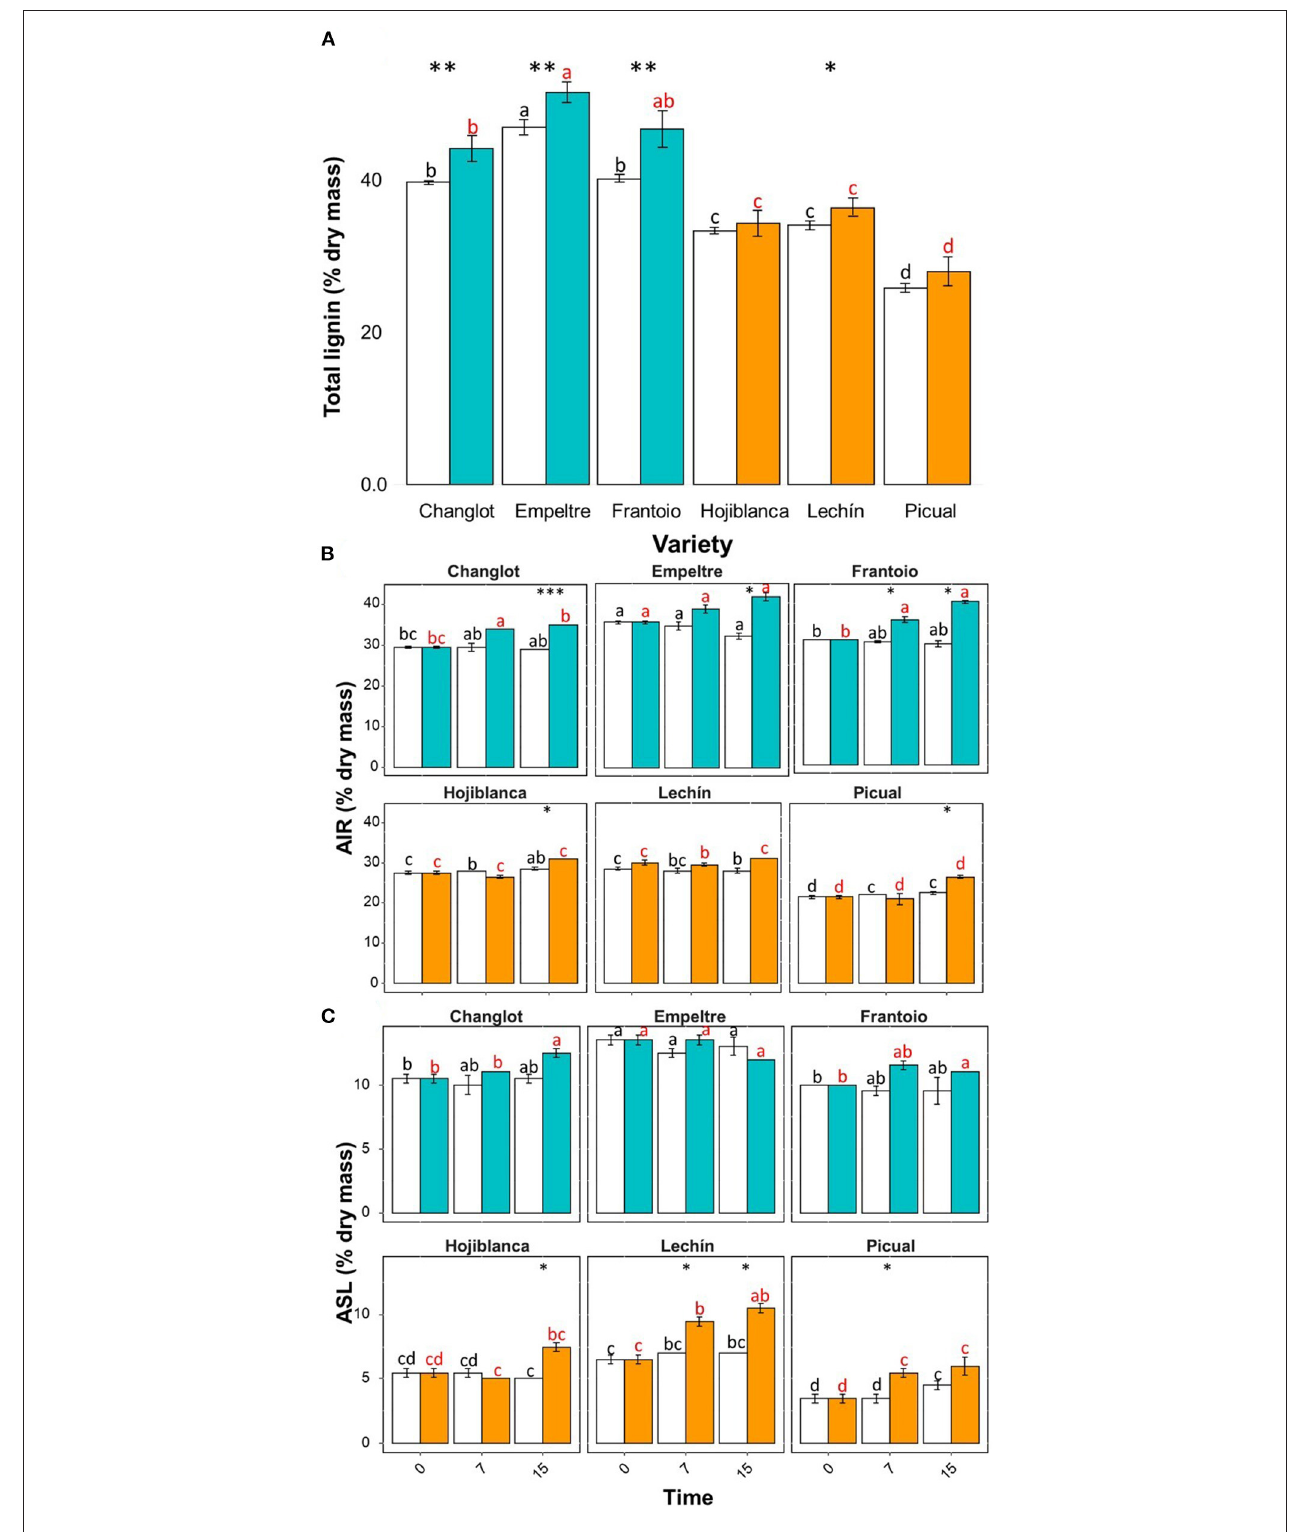
FIGURE 7 | Total lignin (A) , acid-insoluble residue (AIR). (B) and acid-soluble lignin (ASL) (C) contents for the six olive varieties under study considering threetime-points(0,7,and15DAI)afterinoculationwith Verticilliumdahliae .InPanel (A) ,dataaretheaverageofnineplants( n =